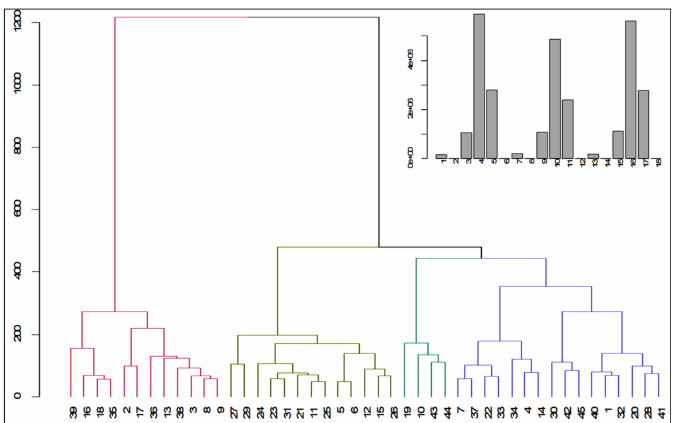
Figure 2. Dendrogram showing the grouping of genotypes based on AD, ASI, PH, KPE, TKW, and GY traits of all